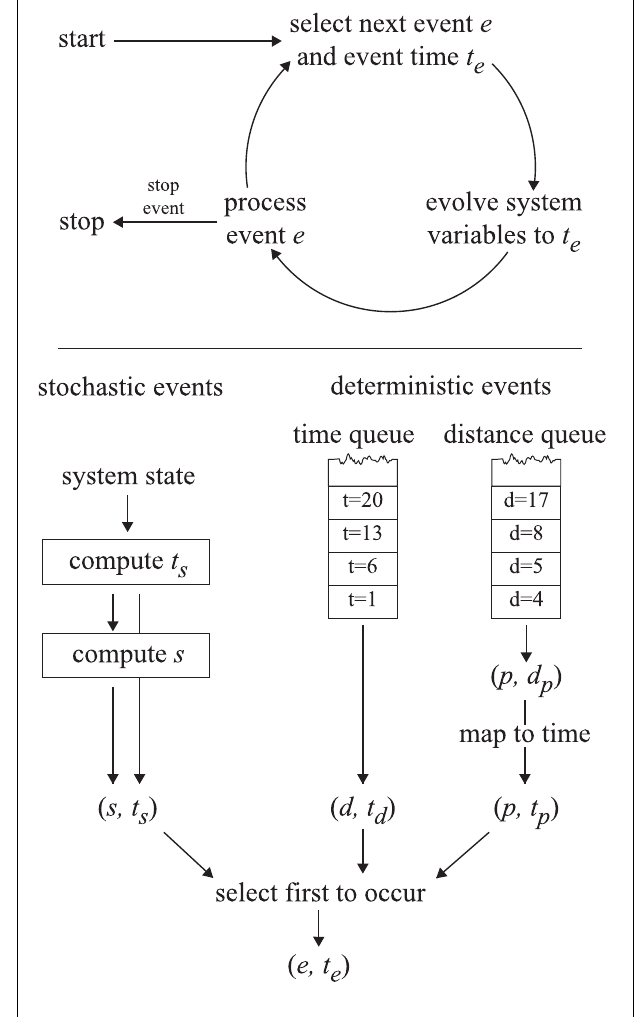
FIGURE 5 | The event-driven simulation process. The top panel illustrates the event-driven simulation cycle. The bottom panel indicates how the first upcoming event is